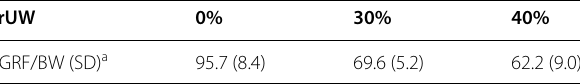
Values represent mean in the each condition (%) Standard deviation (SD) a Statistically significant difference between conditions are noted for α = 0.01